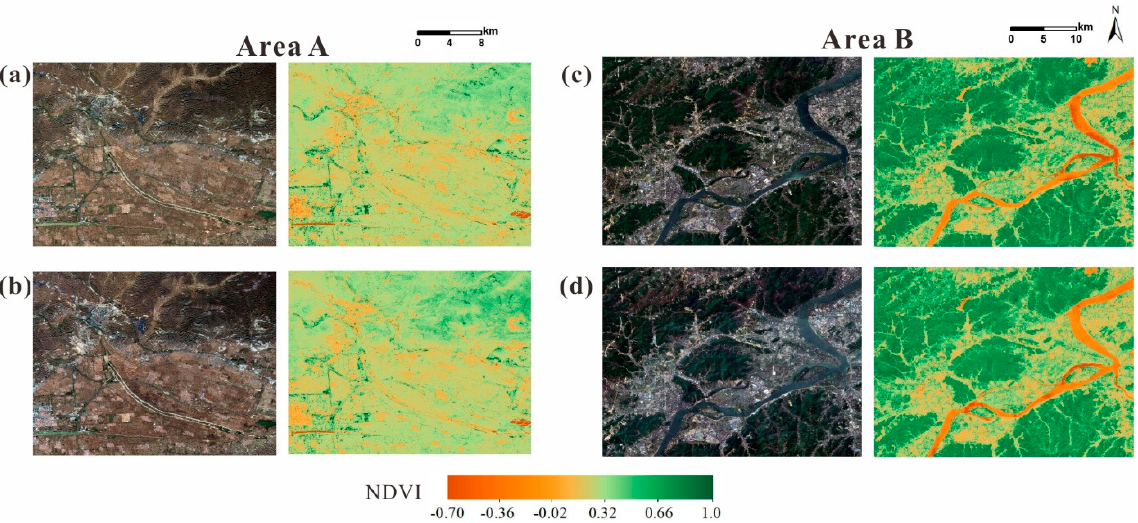
Figure 9. Comparing the actual acquired Sentinel-2 reflectance and NDVI images to their recon- structed correspondence. ( a ) Actual images in Area A (24 October 2020); ( b ) Reconstructed images in Area A. ( c ) Actual images in Area B (28 April 2020); ( d ) Reconstructed images in Area B.